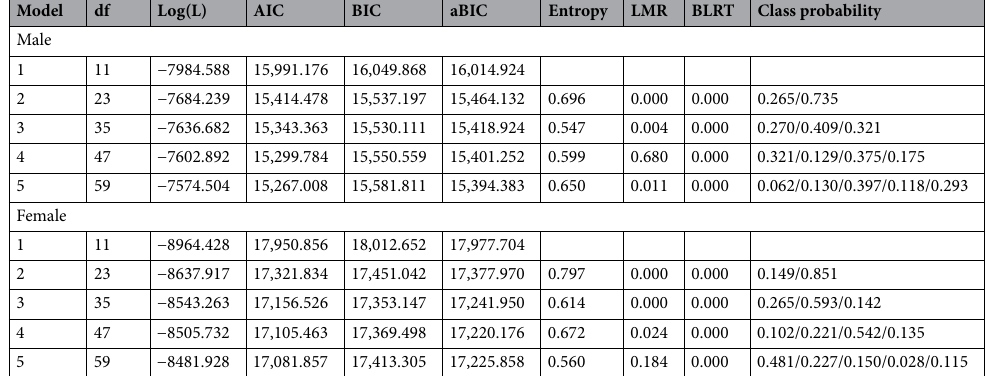
Table 2. The fitting index of latent category model for different categories.